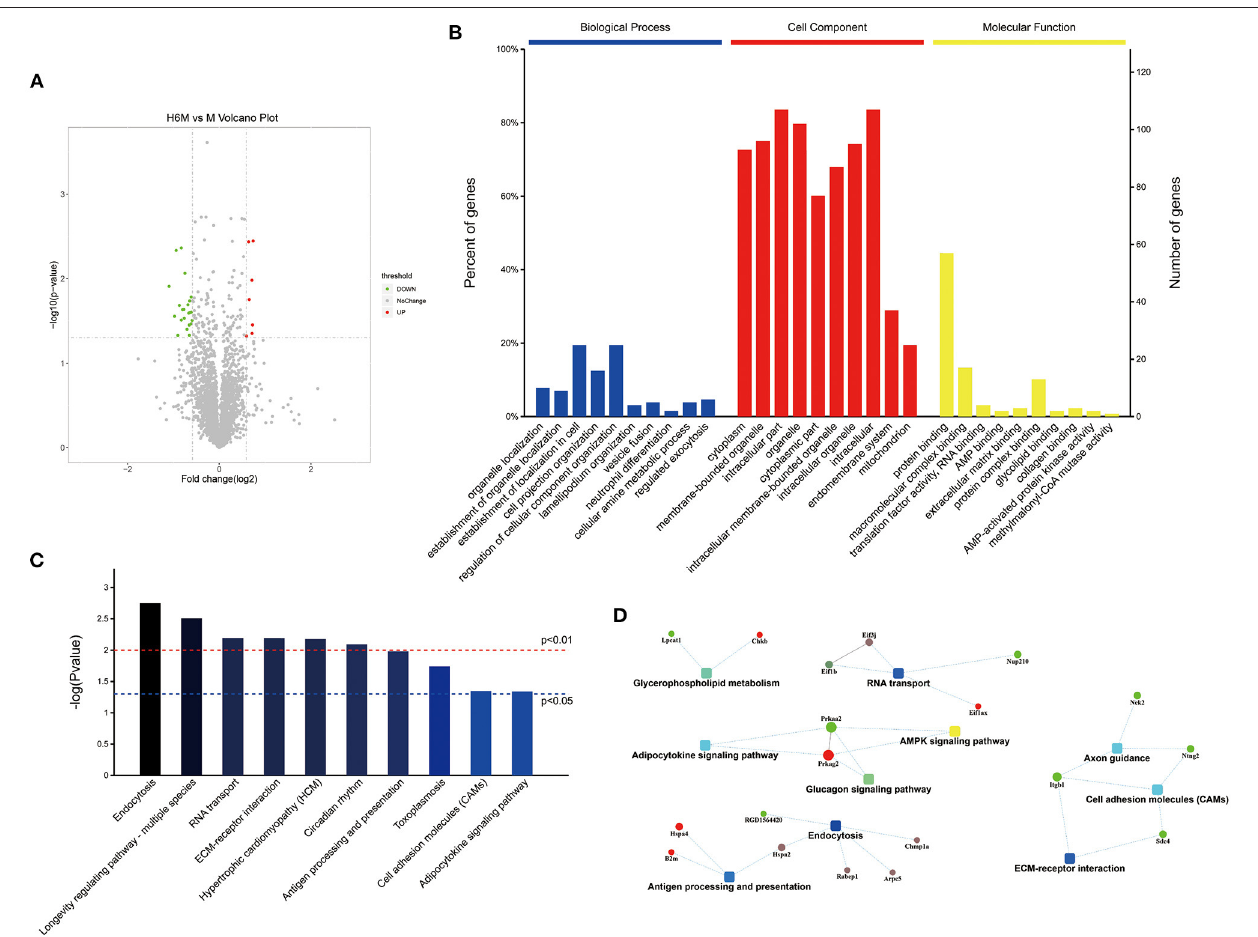
FIGURE 5 | Functional proteomics and bioinformatics analysis between the M and H6M groups ( n = 3). (A) Volcano map of differential protein analysis. The volcano map was drawn by the protein expression difference multiple between the two groups and the p -value obtained by the t -test. The abscissa is the multiple of the difference (logarithmic transformation with base 2), and the ordinate is the significant p -value of the difference (logarithmic transformation with base 10). Red represents the up-regulated protein, green represents the down-regulated protein, and gray represents the protein with no significant difference. (B) GO annotation and enrichment of differentially expressed proteins between the H6M and M groups. (C) Top 10 pathways of KEGG enrichment. (D) Network of the main potential proteins analyzed by MaxQuant. GO, Gene Ontology; KEGG, Kyoto Encyclopedia of Genes and